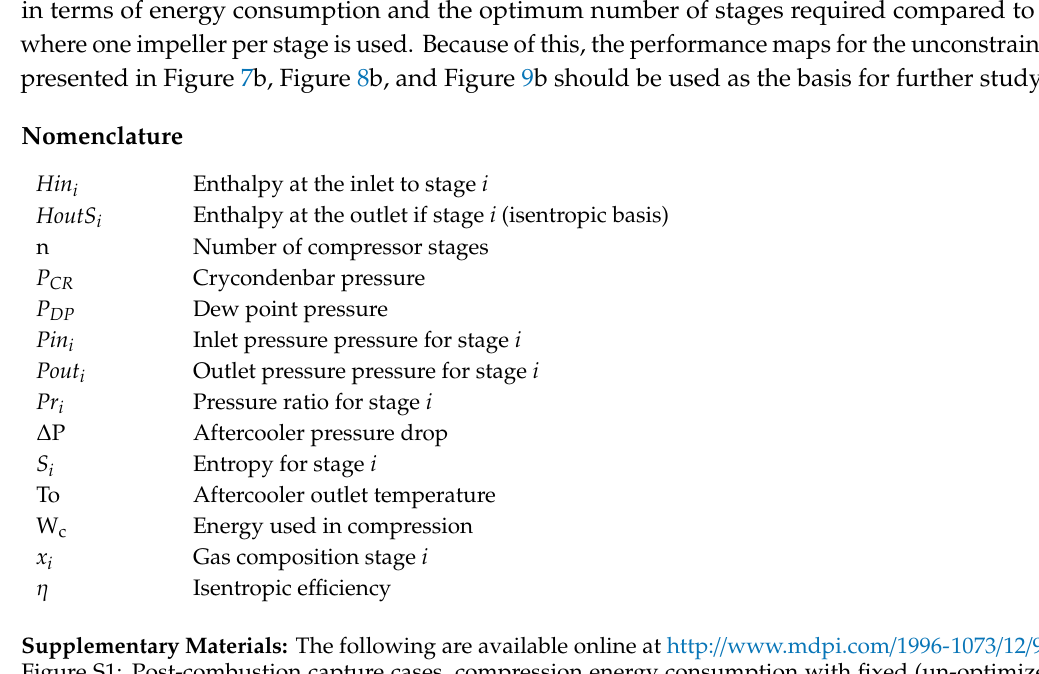
Figure S1: Post-combustion capture cases, compression energy consumption with fixed (un-optimized) stage pressure ratios, ( a ) constrained cases and ( b ) unconstrained cases. Figure S2: Pre-combustion capture cases, compression energy consumption with fixed (un-optimized) stage pressure ratios, ( a ) constrained cases and ( b ) unconstrained cases. Figure S3: Oxy-combustion capture cases, compression energy consumption with fixed (un-optimized) stage pressure ratios, ( a ) constrained cases and ( b ) unconstrained cases. All data from Figures 7–9 and Figures S1–S3 in CSV .txt